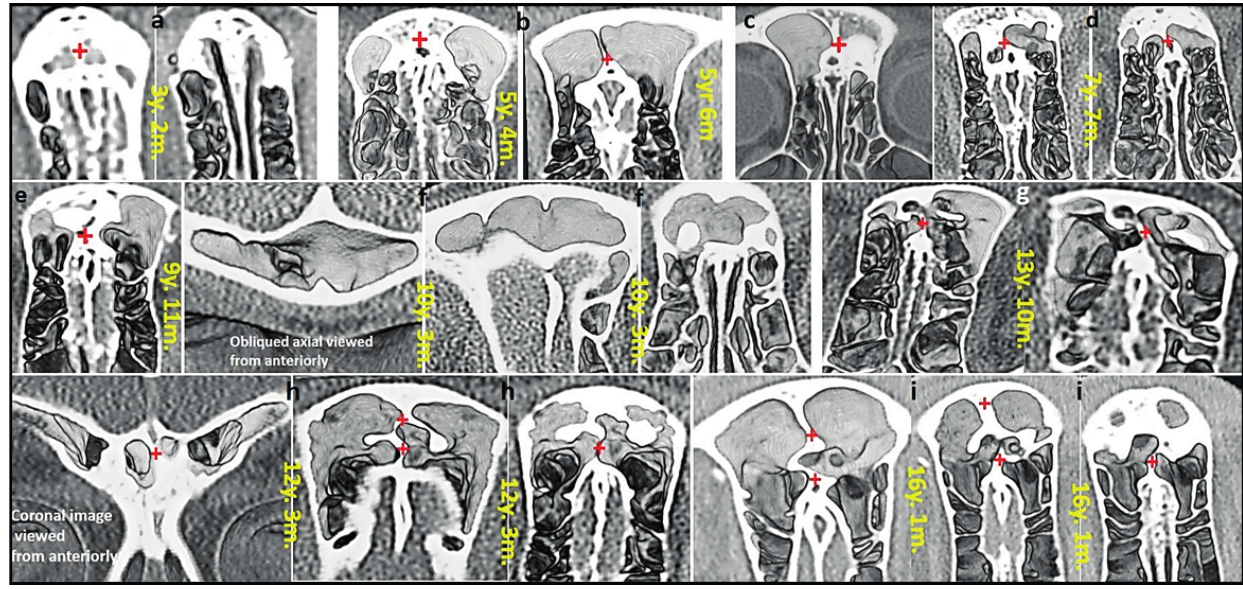
Figure 8. The Frontal Sinus & Septum’s appearance at various ages of development. 3D axial images viewed from above, except for two 3D coronal images, so indicated on the specific images. The images are at various ages of FS development and demonstrate the variability in FS and inter-frontal sinus septal development. Note that, at age three years and two months, the FS is absent. FS expansion is readily observed after the age of five years, four months. At five years and six months in this patient there is an asymmetry in the FS expansion, with a “thin” paramedian frontal septum created by the “collocation”/fusion of the medial boundaries of the expanding right and left FS. ". The asymmetry of the FS and the unilateral expansile nature of a single sinus (at 10 years, three months) is shown. Similarly, in a patient at 12 years, three months, the anterior coronal image may lead one to consider the presence of an inter-frontal sinus septal cell, however, the 3D axial images reveal that bony ridges in the floor of the FS adhere to the frontal septum, creating a distorted frontal sinus, which gives the appearance of an IFSSC. Similar bony ridges in the outline of the “excavated” frontal bone affect the frontal septum in the patient at 16 years, one month. Frontal sinus septum